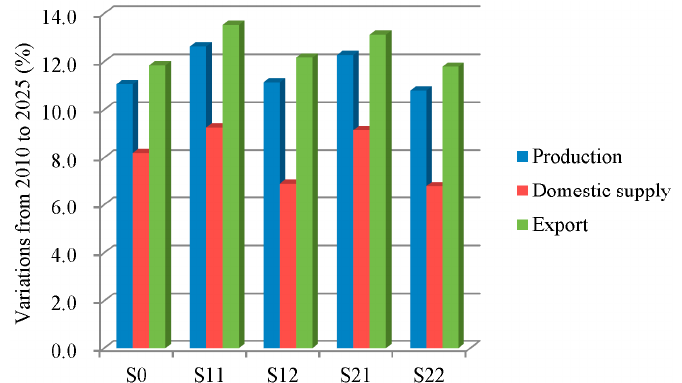
Figure 2. Production, domestic supply, and export variations from 2010 to 2025 (%).